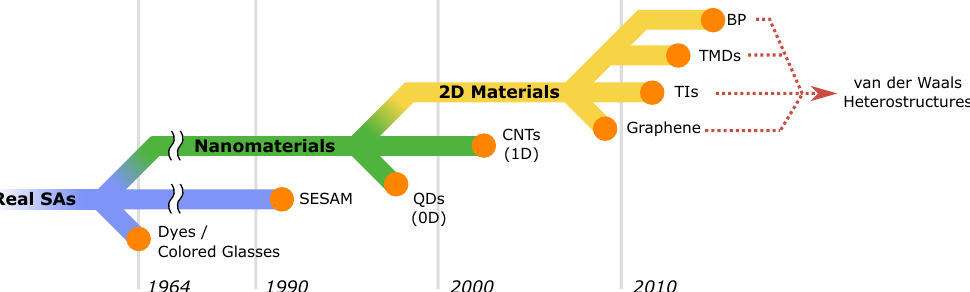
Figure 1. The evolution of real saturable absorber technologies. Orange dots denote the first reported application of each technology in a pulsed